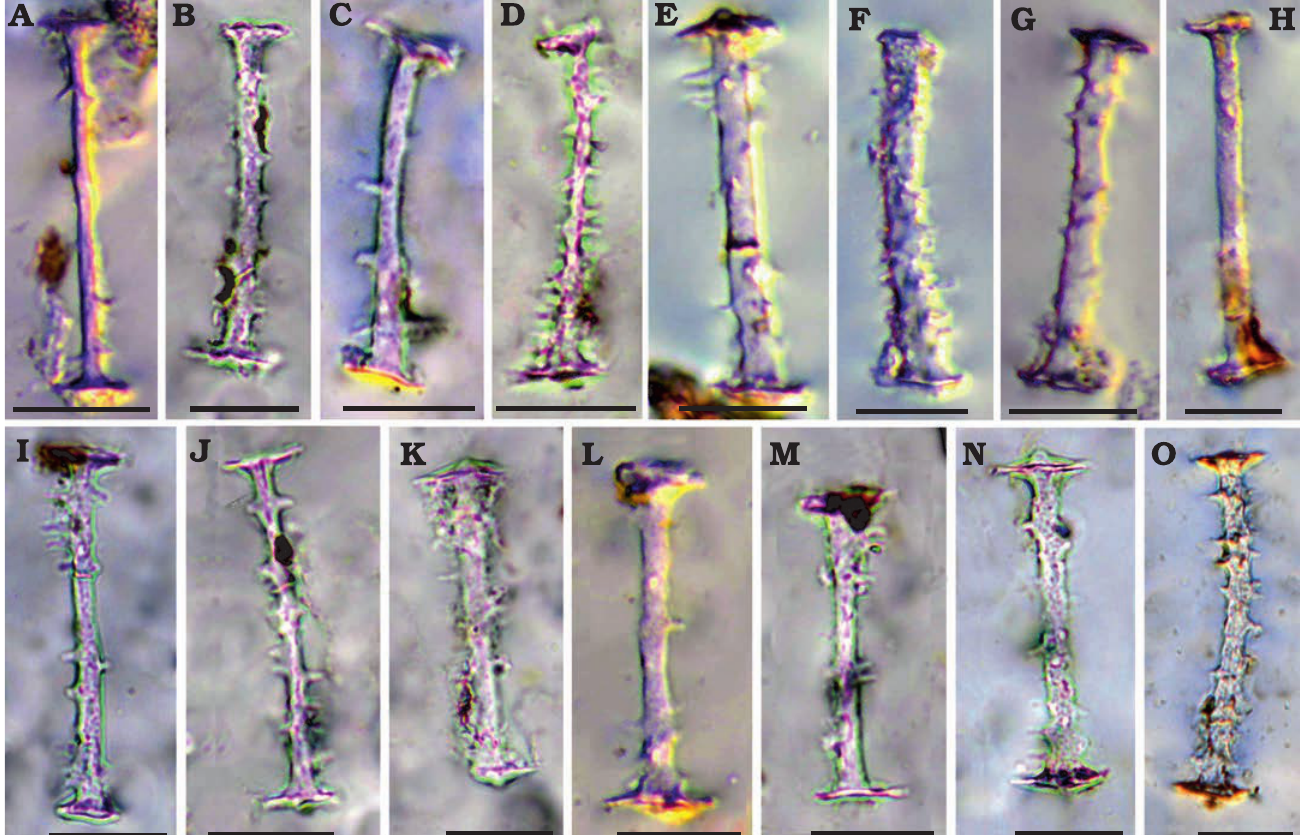
Fig. 4. Gemmuloscleres of palaeospongillid sponge Longibirotula antiqua gen. et sp. non. from Upper Cretaceous–lower Paleocene of Naskal GSI Quarry (India). A – O . Birotules (slides PGNU/NSKQ/SL-1–13) slender, spiny, with long shaft. Diagenetic processes affect all spicules to various degree. Scale bars 20